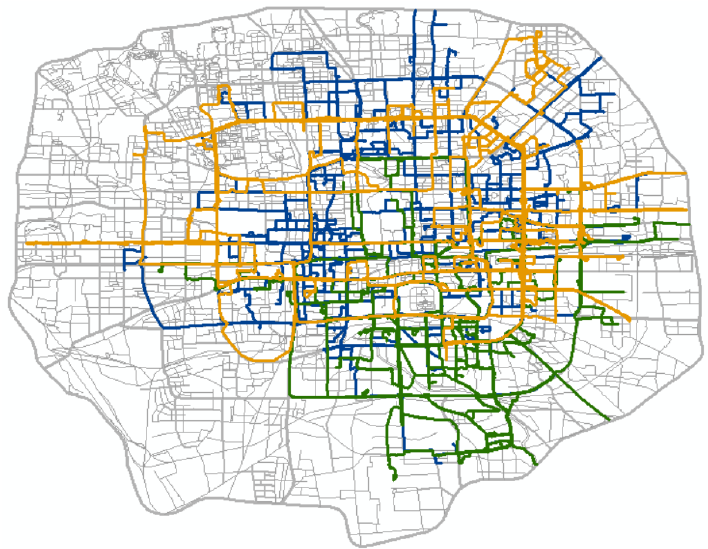
Figure 6. Road network and trajectory data. Gray lines are the road network. Color lines are trajectory data, where the blue lines are data 1, the orange lines are data 2, and the green lines are data 3.